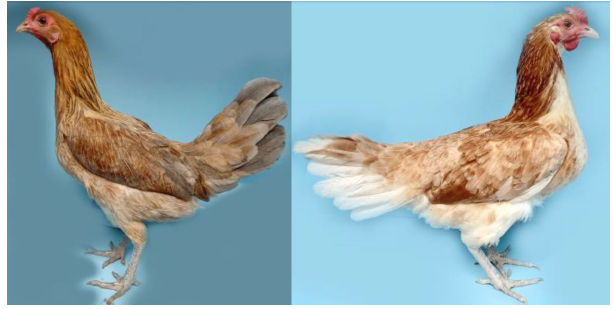
Figure 1. Morphology of the IPB D-1